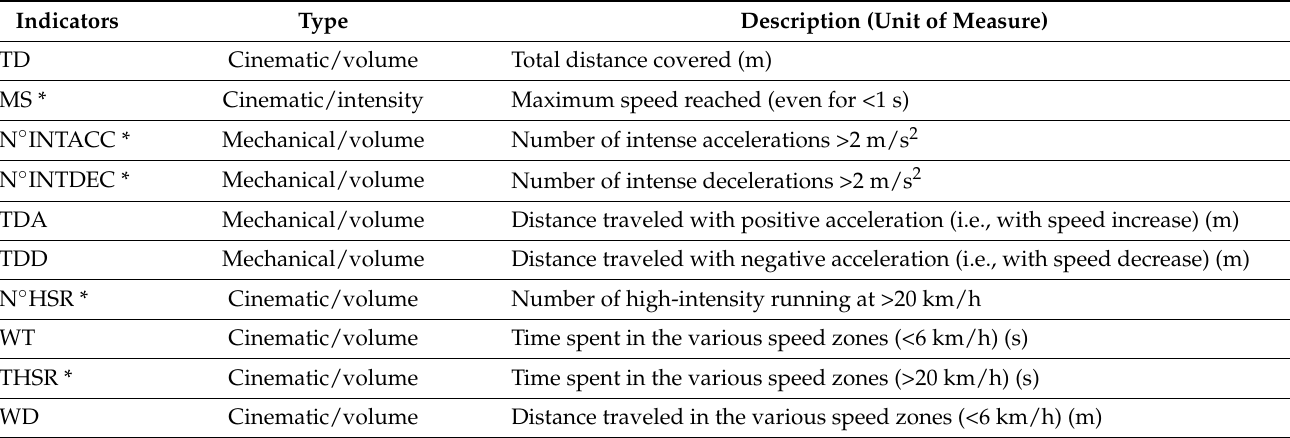
Table 1. Descriptions of the external load